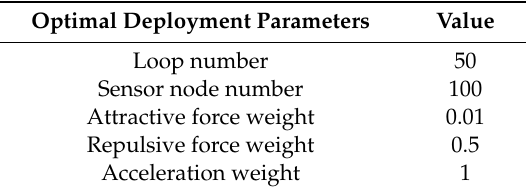
Table 2. The parameters used in the simulation for optimal sensor node deployment.